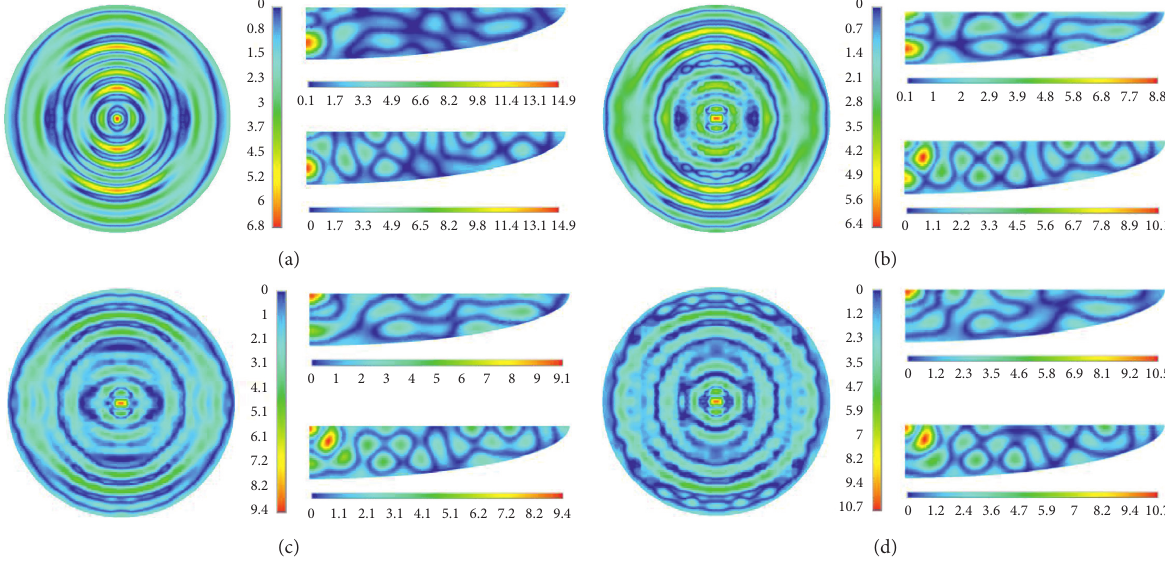
Figure 9: The displacement amplitude of the homogeneous sedimentary basin ( f � 3.0 Hz): (a) no buildings; (b) buildings 14 × 14; (c) buildings 20 × 20; (d) buildings 26 ×